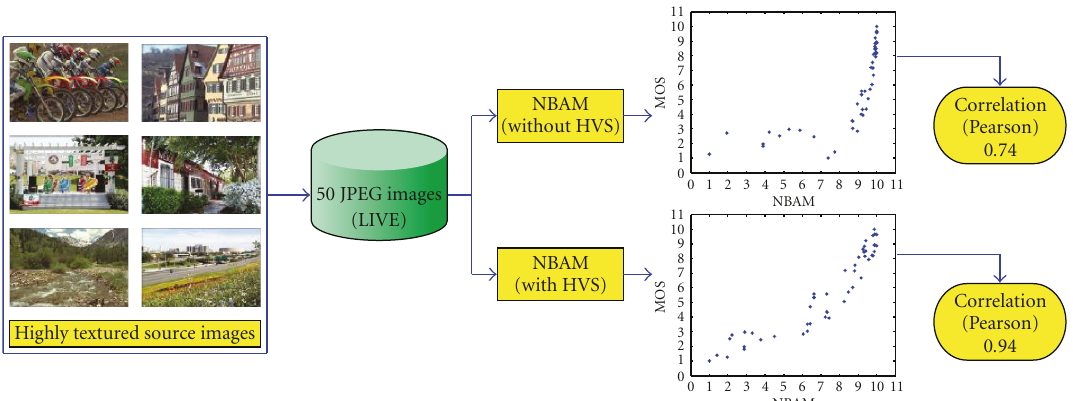
Figure 13: Illustration of the added value of including an HVS model in a blockiness metric: a database of 50 highly textured JPEG images was extracted from the LIVE database, and blockiness annoyance was estimated with the metrics NBAM (without HVS) and NPBM (with HVS). The prediction performance is given in terms of the Pearson correlation coe ffi cient.